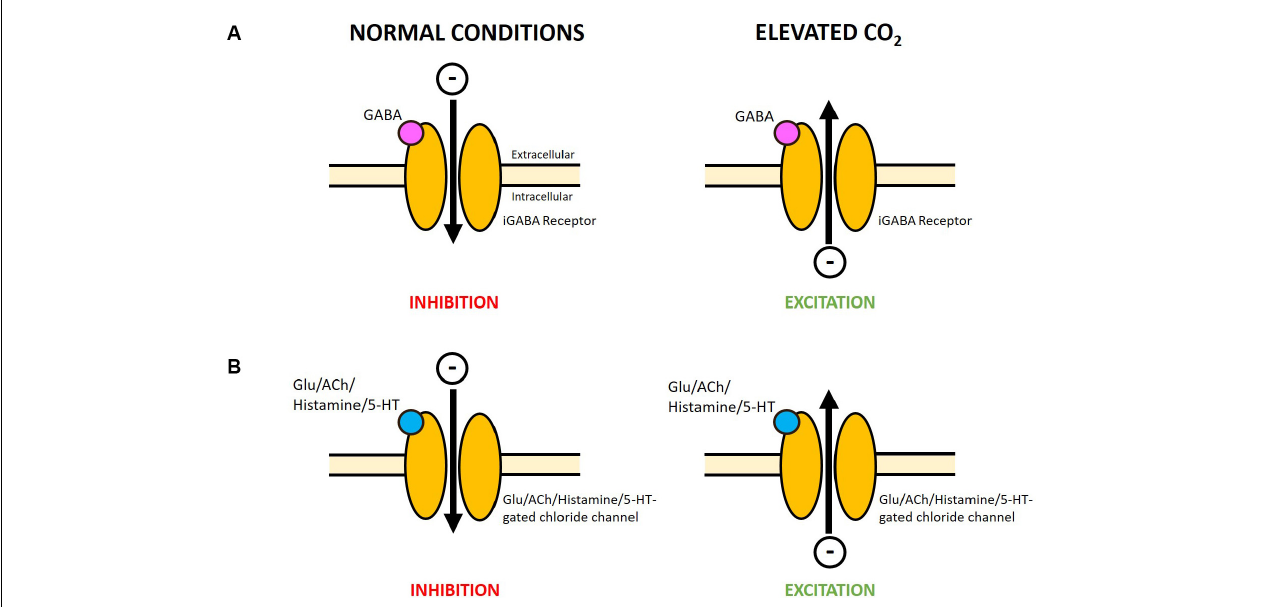
FIGURE 2 | Potential reversal in function of varying LGICs at elevated CO 2 in marine invertebrates. (A) A change in HCO 3 − and Cl − gradients across the neuronal membrane, due to acid–base regulation at elevated CO 2 , was proposed to reverse the net flow of negative charge through the GABA A R (Nilsson et al., 2012) and likely applies to the marine invertebrate iGABA R. Under normal conditions the net influx of negative charge is primarily carried by Cl − , while at elevated CO 2 the net efflux of negative charge may be primarily carried by HCO 3 − (see Heuer et al., 2019 for a detailed explanation). (B) A range of invertebrates also possess glutamate, acetylcholine, histamine and serotonin-gated chloride channels. The flow of Cl − through these channels may be similarly altered at elevated levels of CO 2 . Research is needed to determine whether these receptors are also permeable to HCO 3 − which could also contribute to the reversal of the net movement of negative charge. A net influx of negative charge will result in hyperpolarization and inhibition of neuronal firing, while a net efflux of negative charge will cause depolarization and excitation. Glu, glutamate; ACh, acetylcholine; 5-HT,